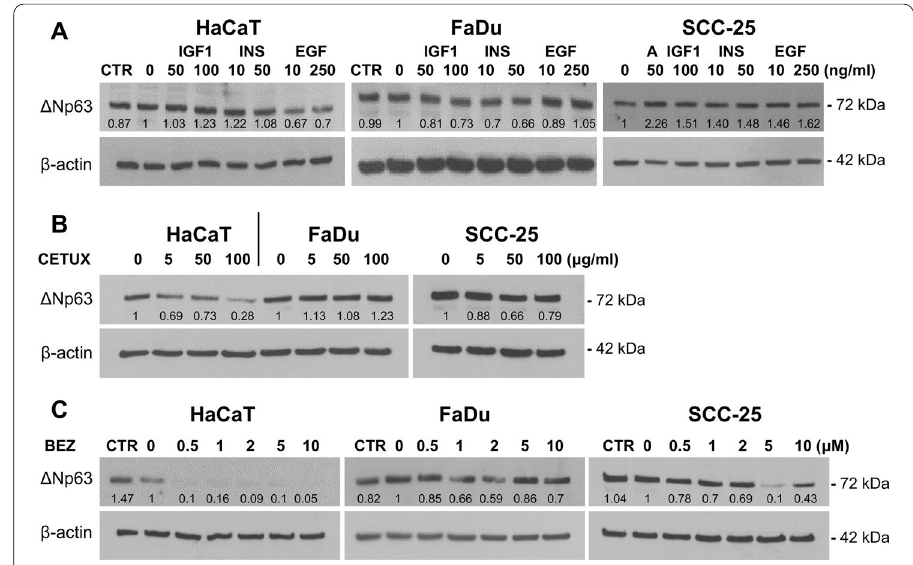
Fig. 3 The effects of growth factor signaling pathways. Representative western blots of ΔNp63 (72 kDa) in HaCaT, FaDu or SCC-25 cells grown for 16 h in 1% FBS and collected after a further 24 h of treatment with A the indicated growth factors (IGF1, insulin like growth factor-1; INS, insulin; EGF, epidermal growth factor; A, amphiregulin), B Cetuximab (CETUX), C BEZ235 (BEZ). β-actin (42 kDa) is shown as the loading control. CTR represents growth in standard medium (10% FBS); 0 represents growth in 1% FBS with no addition of growth factor or inhibitor. Relative ΔNp63 densitometry measurements normalized to β-actin are indicated for the representative blots shown, with 0 used as control. See Additional file 6 for other growth factors